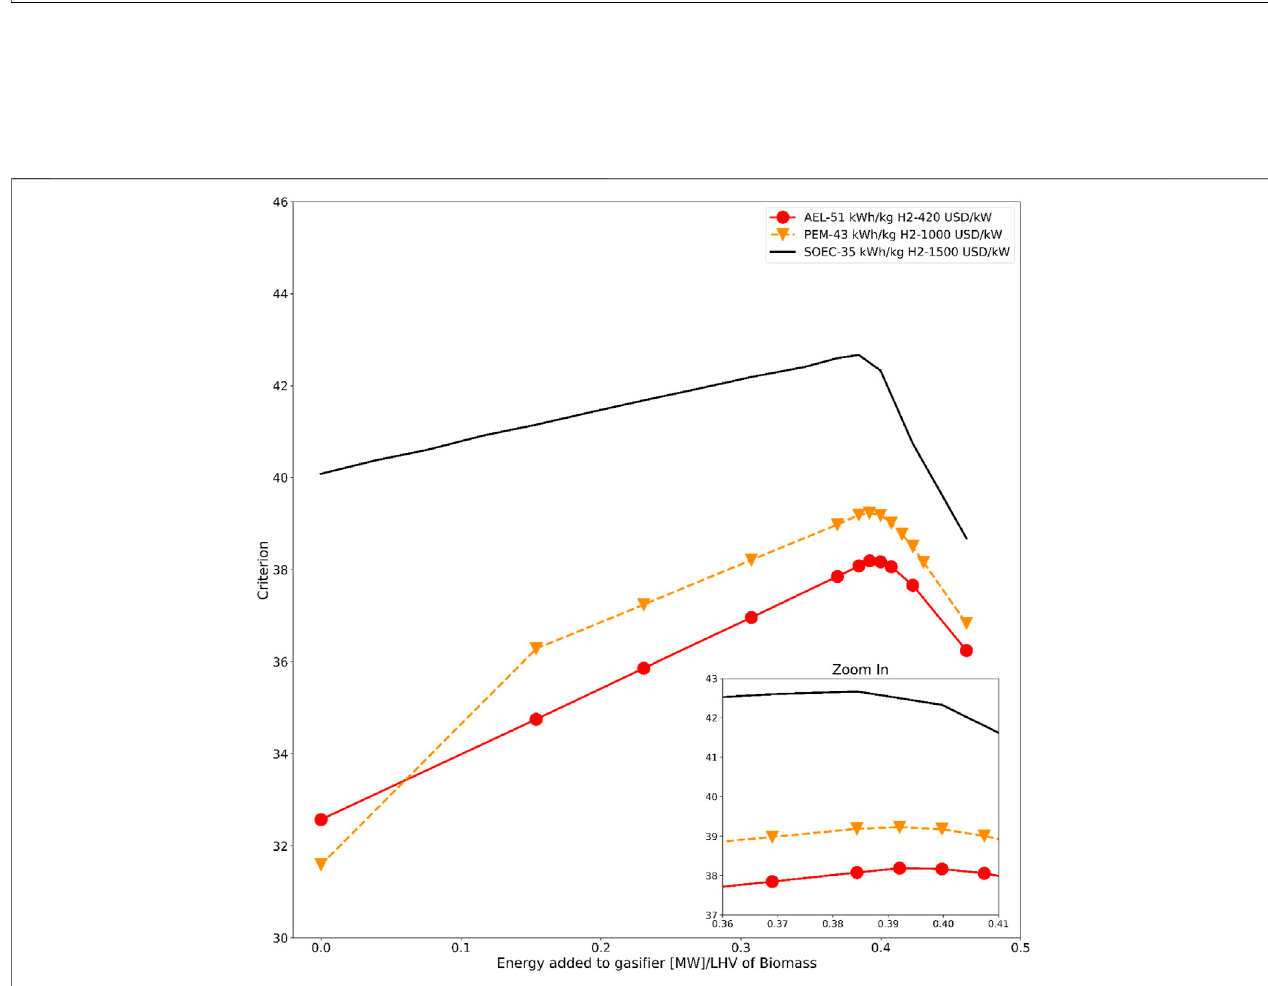
FIGURE 7 | Amount of energy added to gasi fi er vs economic criterion J for different electrolyzer technologies.